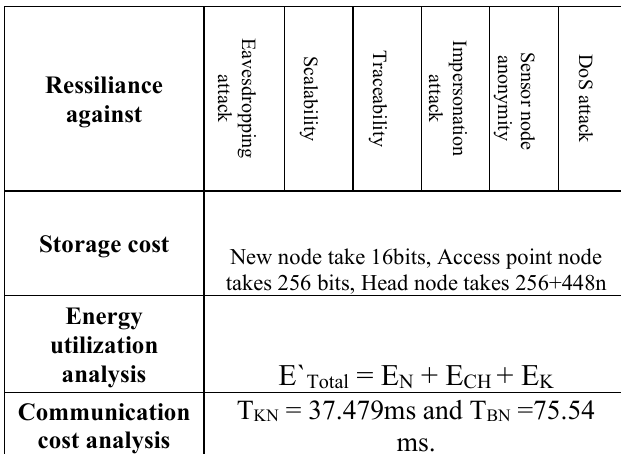
Table 3. Summary of result